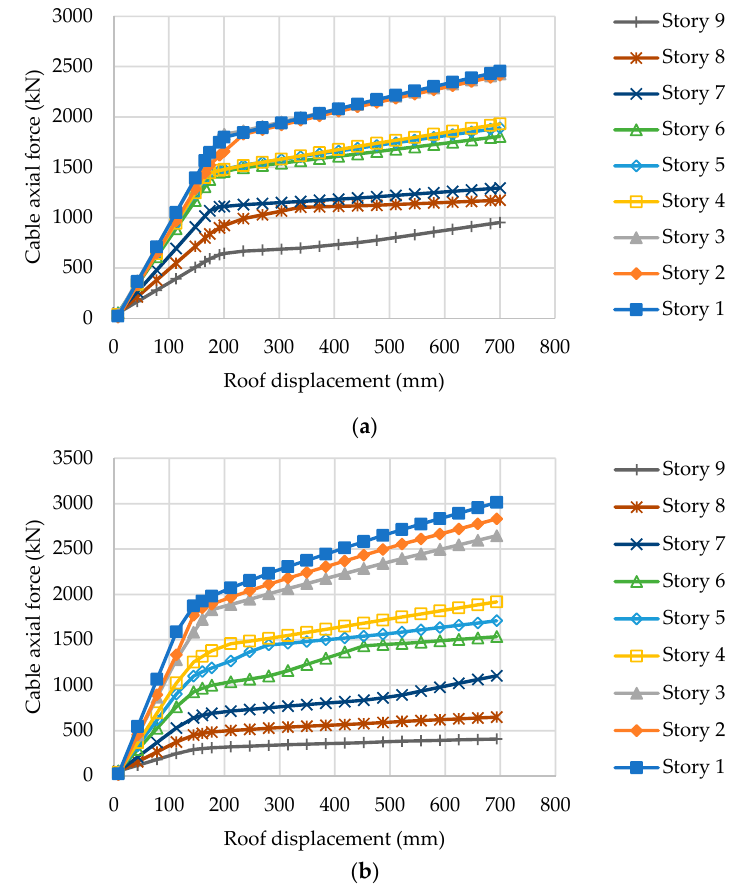
7 of 17 Figure 6. Lateral load distributions: ( a ) parabolic distribution (LD-P) and ( b ) uniform distribution (LD-U). 3.1. Force Response As shown in Figure 7, the SC-TOBFs exhibit a bilinear base shear response with a significant stiffness reduction when the yield-like activation is attained, similar to the softening behavior of yielding systems, facilitating limiting the seismic forces induced in the structures. The activation initiates at 𝛥 (cid:3009) = 200 mm (corresponding to 𝜃 (cid:3009) = 0.57%) and 𝛥 (cid:3009) = 150 mm (corresponding to 𝜃 (cid:3009) = 0.43%) under LD-P and LD-U, respectively. Figure 7. Base shear response.